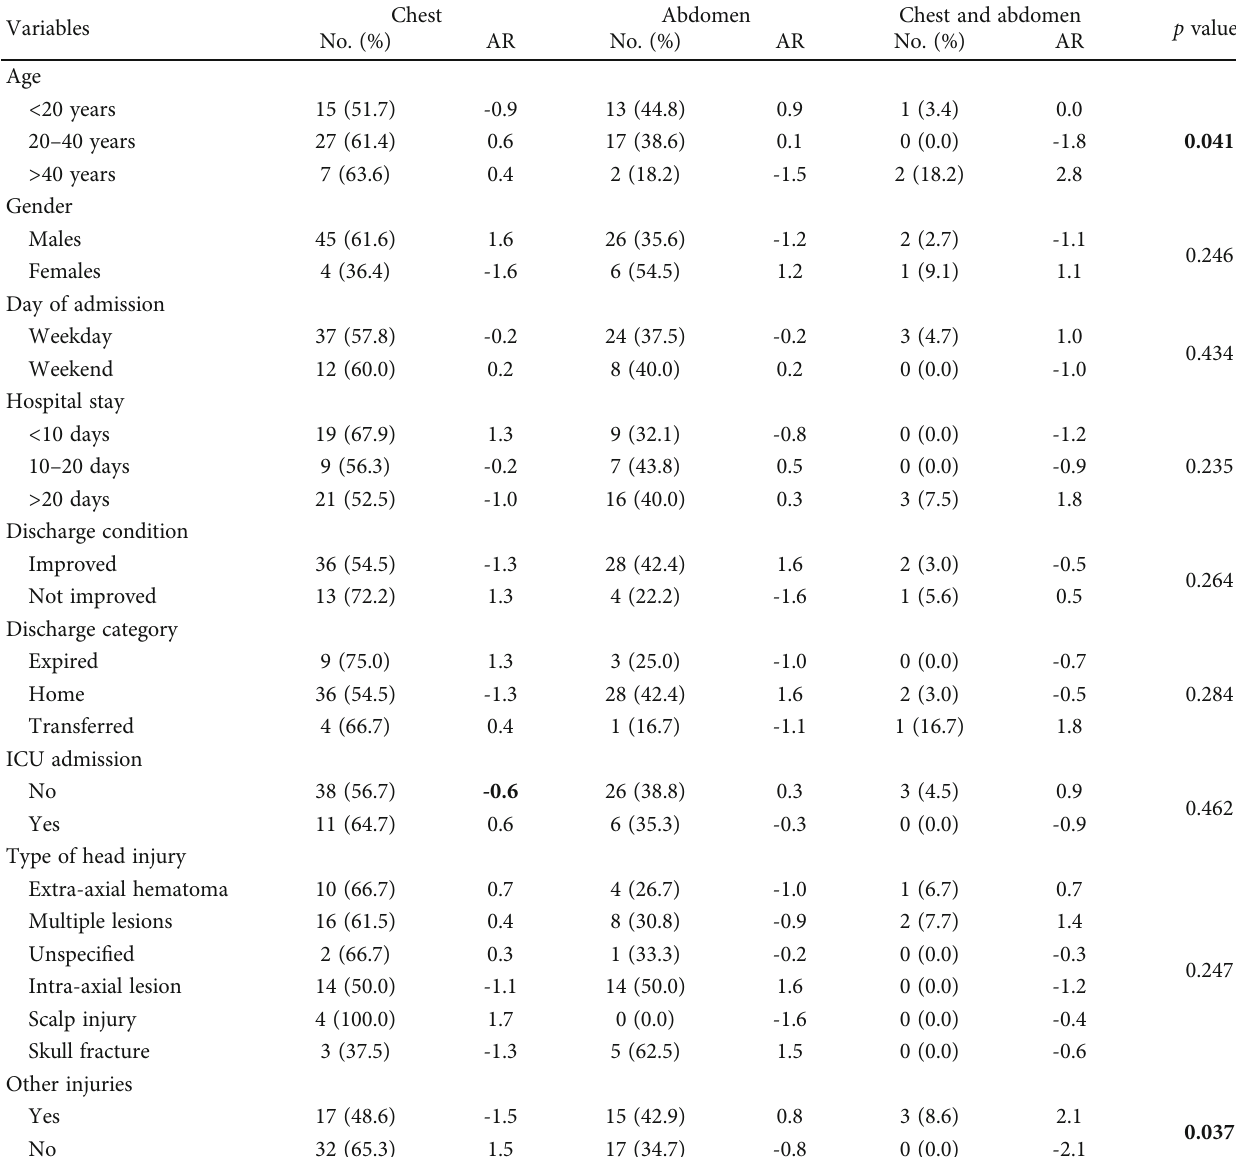
Table 3: Association between the di ff erent variables and thoracoabdominal injuries ( n = 84